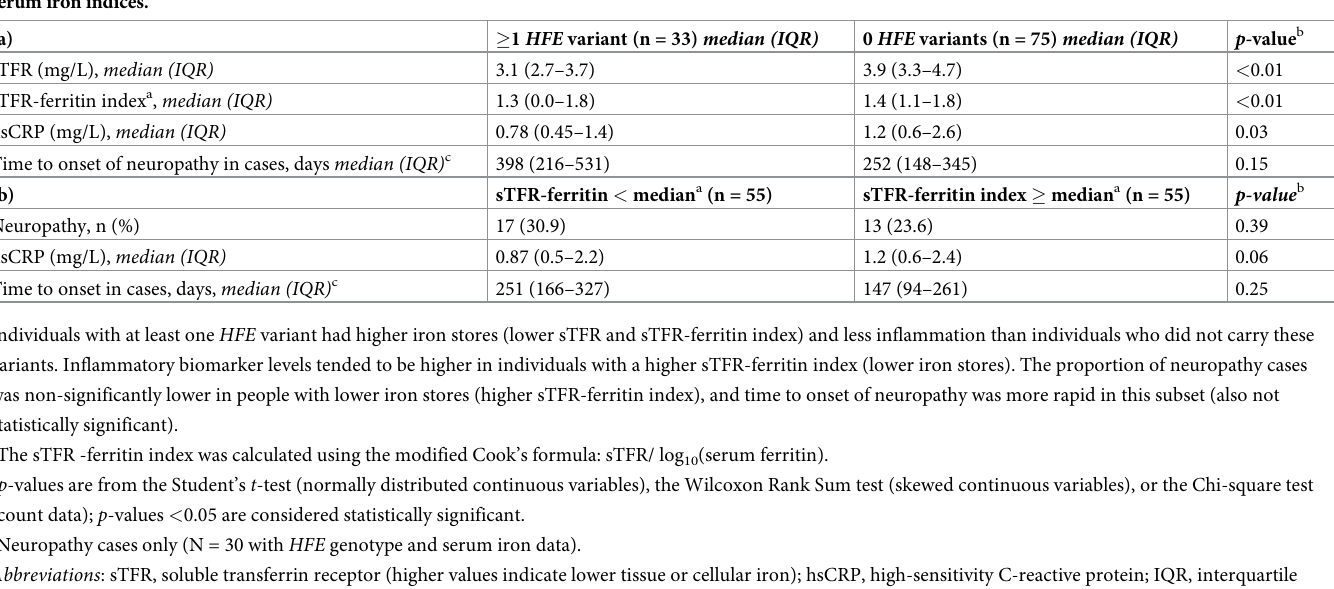
Results of analyses adjusted for age, CD4+ T-cell count, plasma HIV RNA, and randomiza- tion (yes/no) to the ddI/d4T-containing arm are presented for all 43 neuropathy cases with genotype data, and for 28 self-reported whites with neuropathy, HFE and serum iron indices,